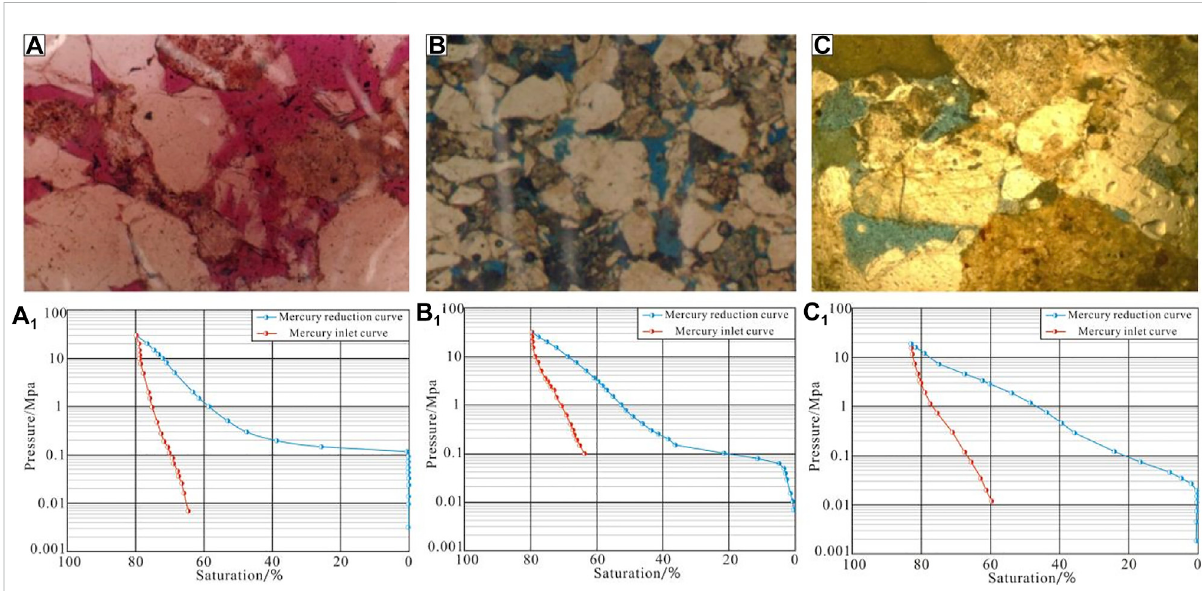
FIGURE 9 Microscopic characteristics of underwater distributary channel reservoirs at different depths and corresponding mercury intrusion characteristics. (A) a 1 . G65-1, 3225 m, median particle size 0.32 mm, mud content 3%, sorting coef fi cient 1.76, pore throat radius: 3.73 μ m; (B) b 1 . G62-35,3602 m,medianparticlesize0.3 mm,mudcontent2%,sortingcoef fi cient1.85,porethroatradius:1.48 μ m; (C) c 1 .G66X5,4285 m,median